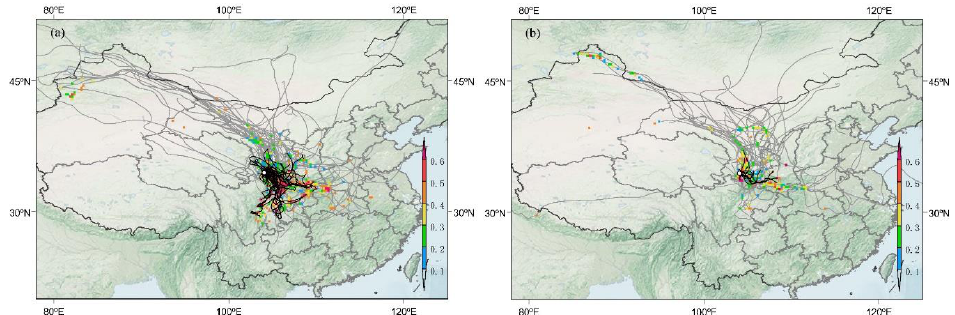
Figure 10. Advective transport of water vapor (grey) and local recycled vapor (black) in the summer half-year ( a ) and winter half-year ( b ) of Minxian Station.